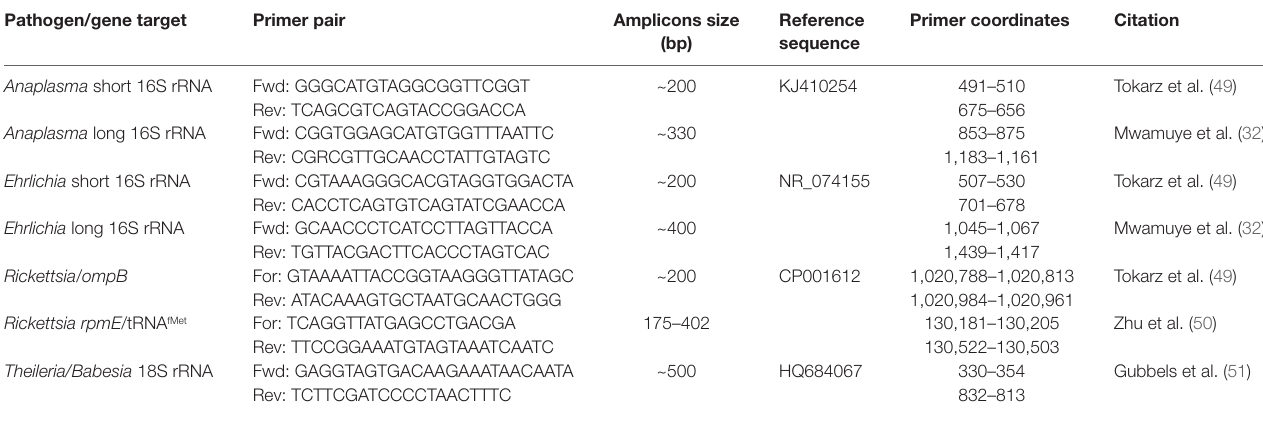
TaBle 1 | Primers used for detection of